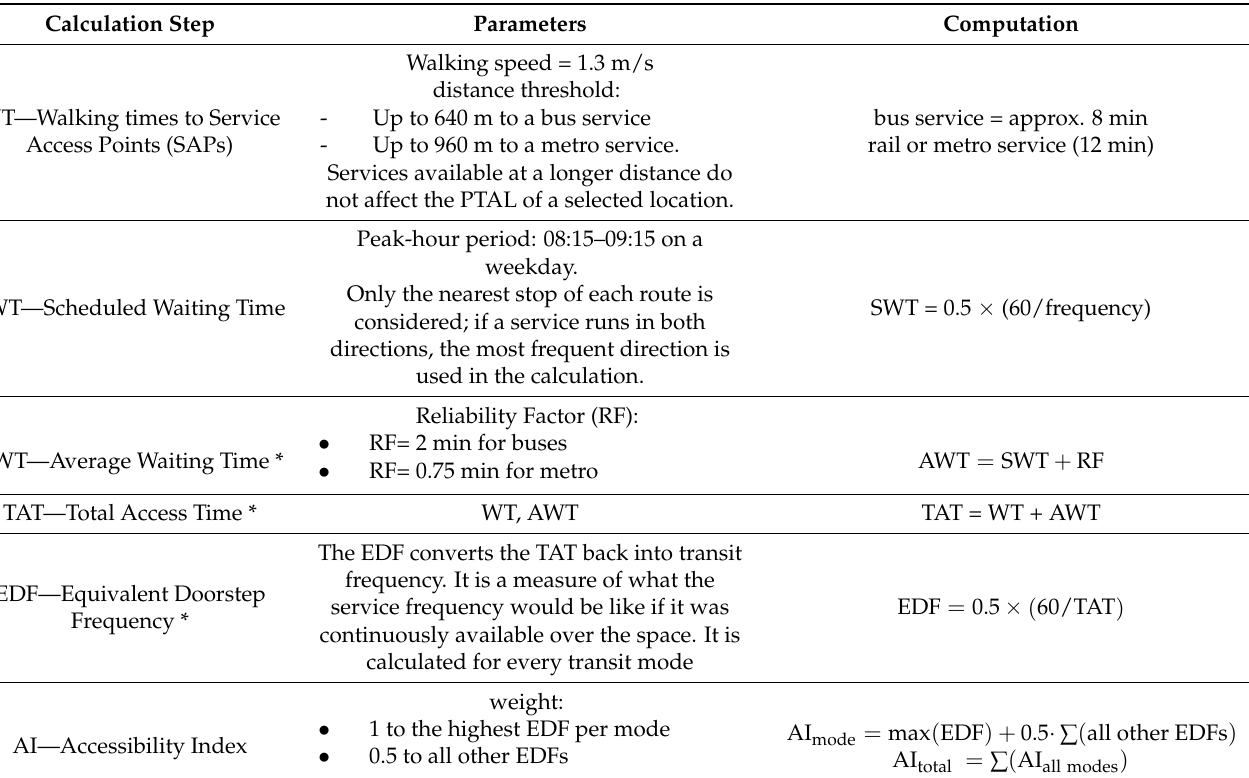
Table 1. Steps for the calculation of Public Transport Accessibility Level (PTAL).